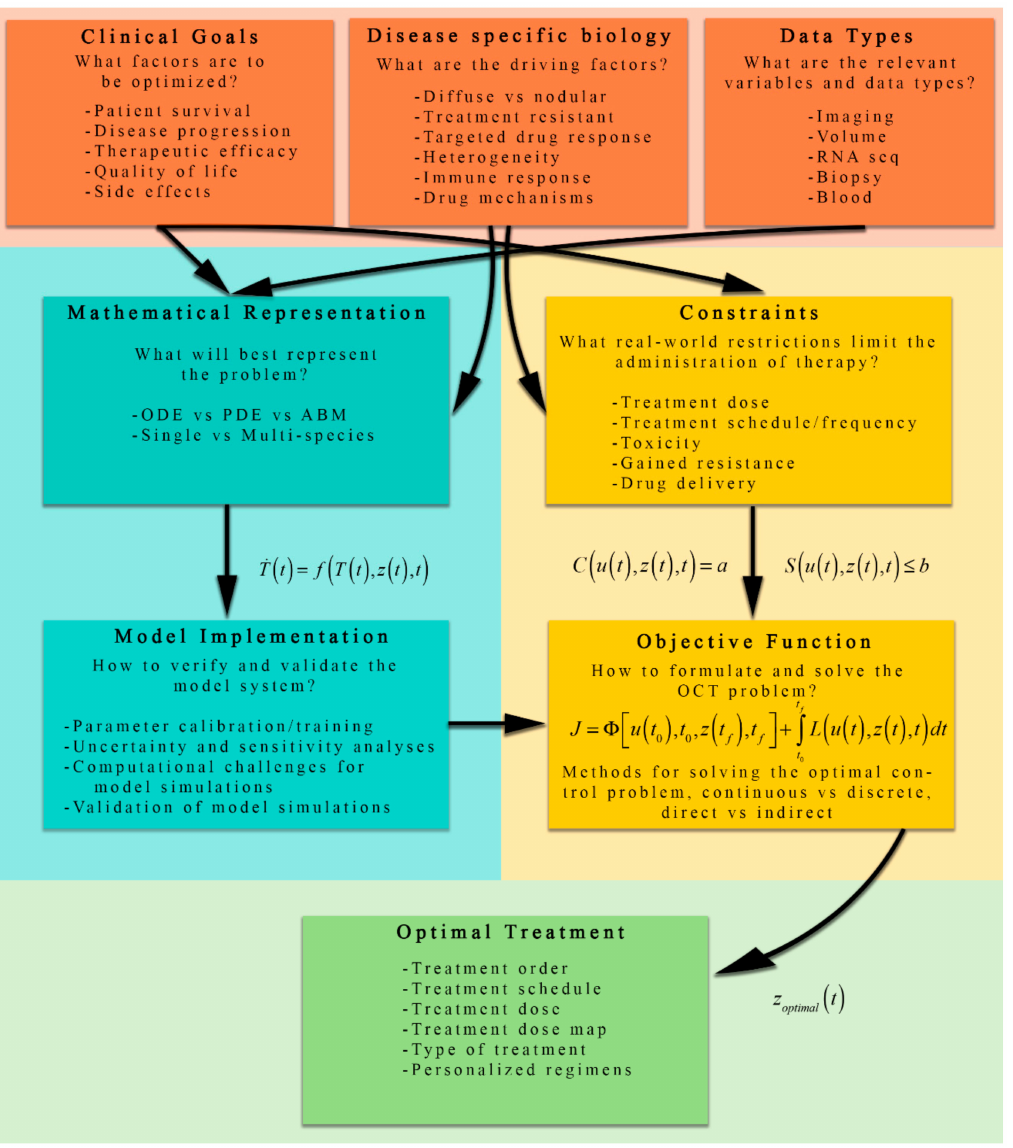
Figure 2. A schematic of the process for formulating OCT problems for cancer therapeutic regimens. The orange boxes represent key factors that influence the mathematical representation (teal boxes), optimal control implementation (yellow boxes), and eventually the optimally selected treatment (green box). Clinical goals, disease-specific biology, and available data influence both the development of the mathematical representation (i.e., the model) and the identification of constraints critical to using OCT to solve the problem. The mathematical representation of the dynamic system is then implemented numerically. The OCT structure uses the constraints (derived from real-world considerations) and the implemented model to systematically evaluate the objective function to determine the optimal